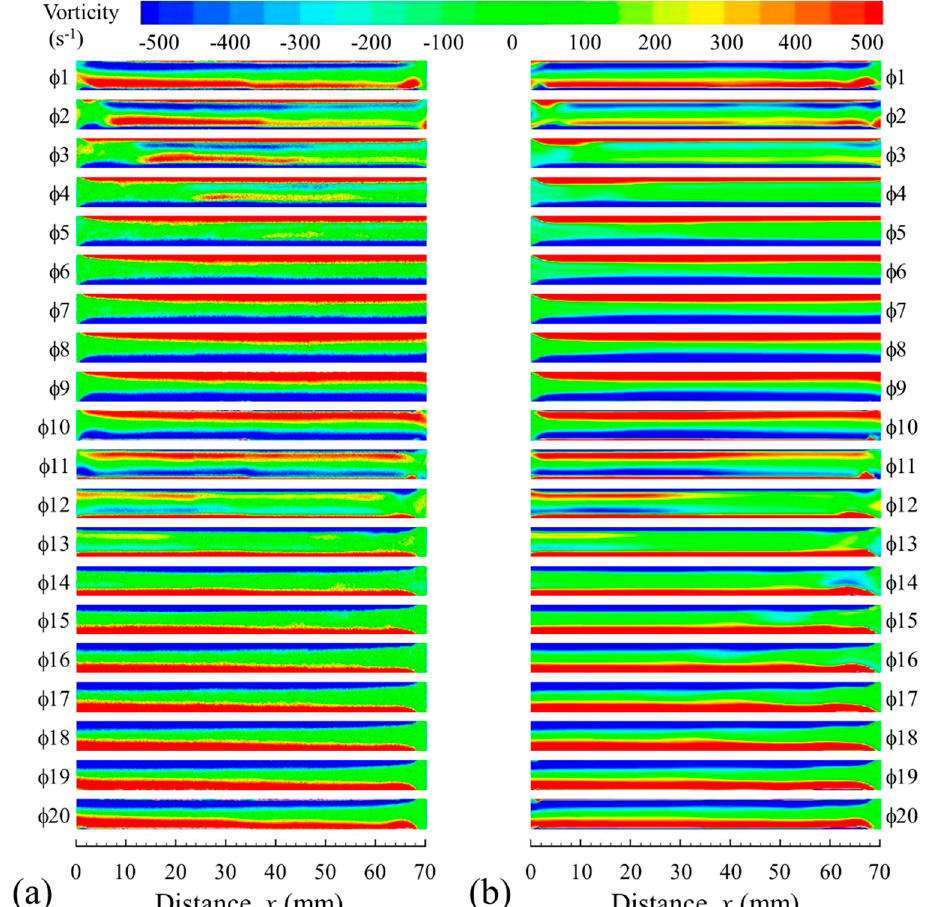
Figure 11. Velocity profiles from the SST k- ω model (black and grey lines) and experiment (red and black symbols). Plotted for the location 10 mm from the joint, inside the cold channel, for the 0.83% drive ratio.